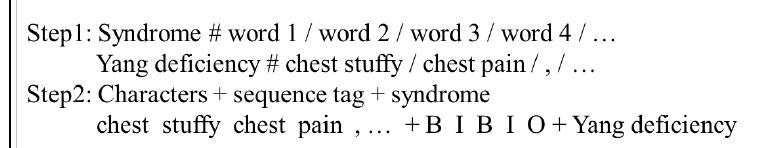
Figure 4. An example of data annotation.